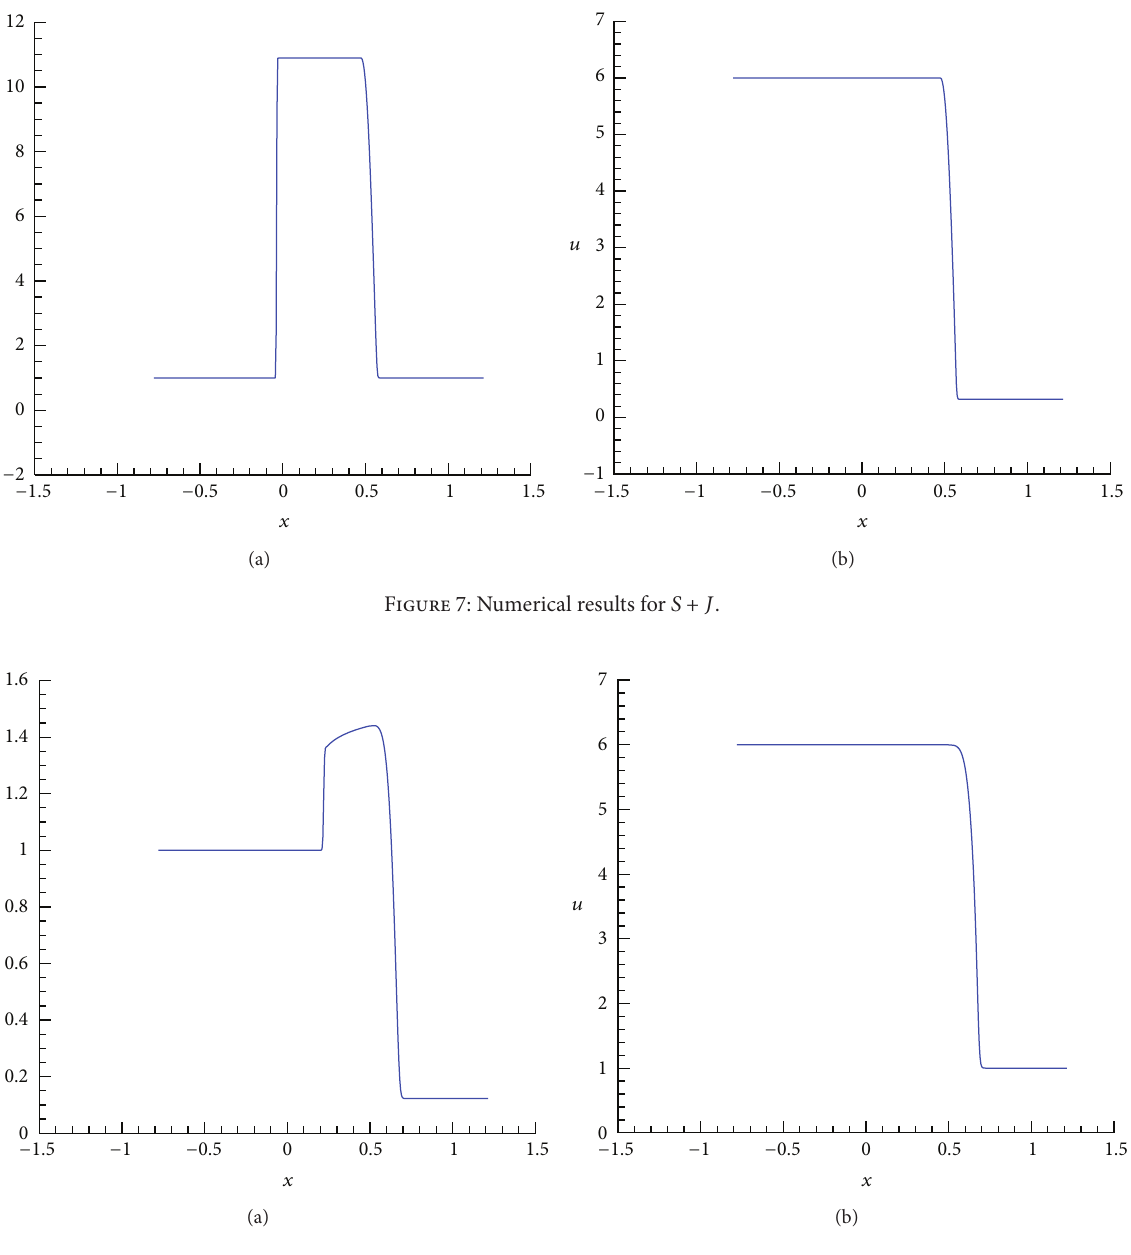
Figure 8: Numerical results for 𝐴 = 2